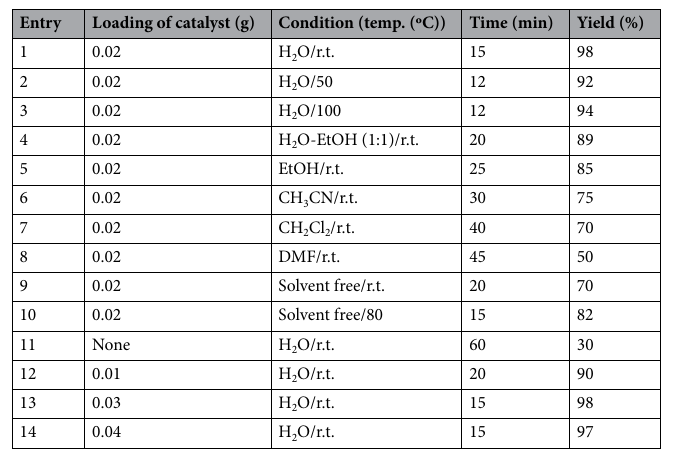
Table 1. Optimization reaction condition using Fe 3 O 4 /s-C 3 N 4 -Starch-Ag As catalyst. Reaction condition: phenylacetylene (1 mmol), benzyl bromide (1 mmol), sodium azide (1.3 mmol), solvent (5